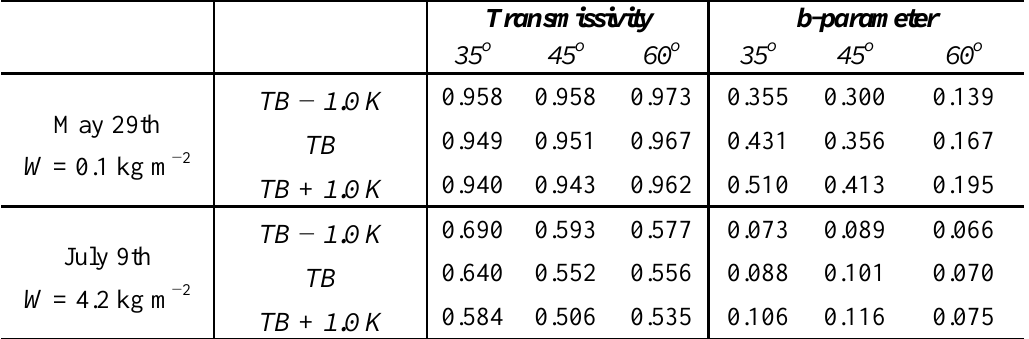
Table 4. H-polarized transmissivities and b parameters inverted from T sparsely (May 29th, W = 0.1 kg m −2 ) and densely (July 9th, W = 4.2 kg m −2 ) vegetated conditions and perturbed by +1.0, 0.0 and −1.0 K,